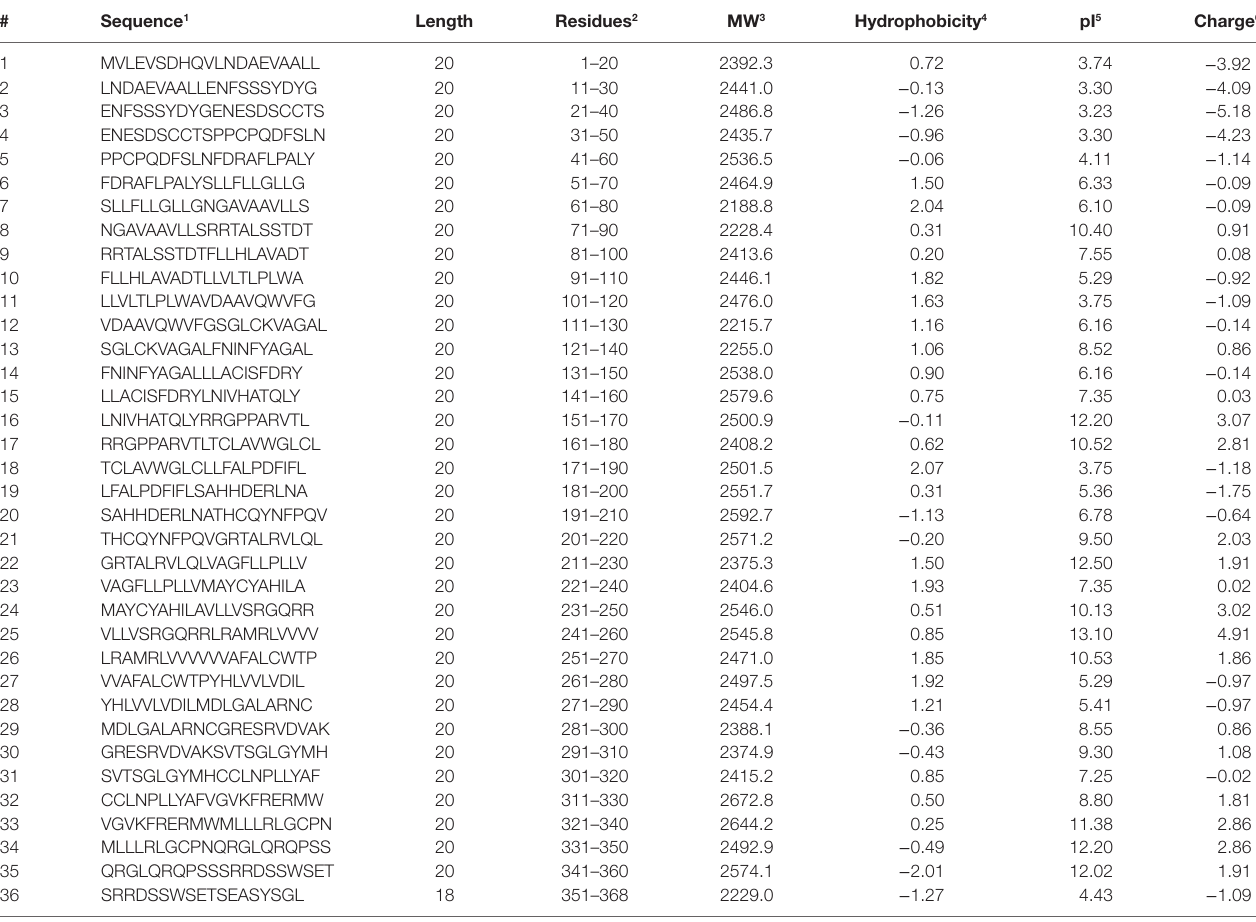
TaBle 2 | Characteristics of peptide fragments of